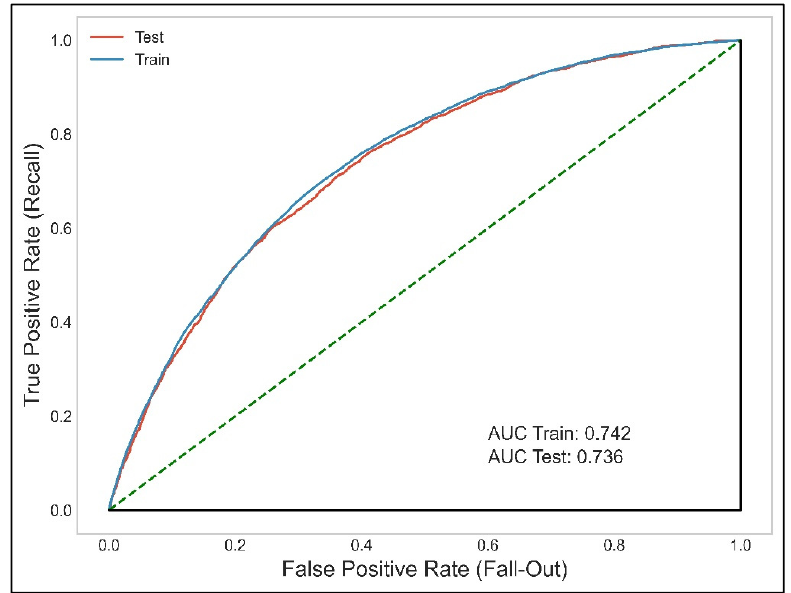
Figure 3. ROC curves for the training and test cohorts. AUC Train: 0.742, 95% CI: 0.737–0.74; AUC Test: 0.736, 95% CI: 0.727–0.746. AUC Train − AUC Test = 0.006, CI difference of the means 0.002–